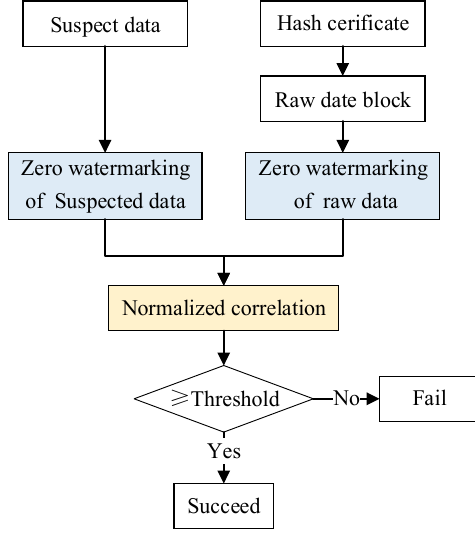
Figure 6. Zero watermarking authentication process.